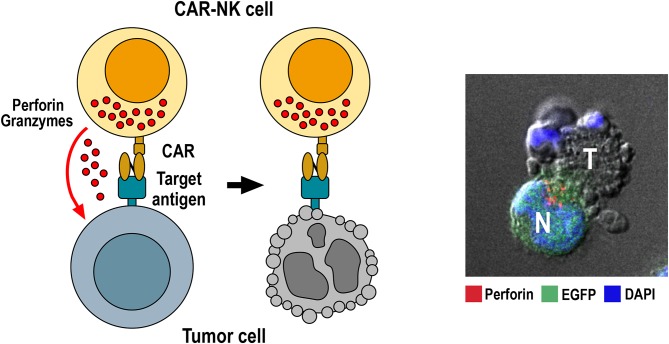
Killing of tumor cells by CAR-NK cells. Specific binding of the chimeric antigen receptor to its target antigen on the tumor-cell surface triggers CAR activation. This results in re-orientation of cytotoxic granules toward the immunological synapse formed between NK and target cell, followed by release of perforin and granzymes from cytotoxic granules into the synaptic cleft. Perforin and granzymes taken up by the target cell then trigger apoptotic cell death indicated by membrane blebbing and disintegration of the nucleus. The confocal microscopy image to the right shows conjugate formation between human GB cells co-expressing EGFR and EGFRvIII with NK-92/225.28.z CAR-NK cells that recognize both target antigens (71). Tumor (T) and EGFP-positive CAR-NK cells (N, green) were co-incubated for 1 h, fixed, permeabilized and stained for perforin (red) to identify cytotoxic granules. Cell nuclei were labeled with DAPI (blue).